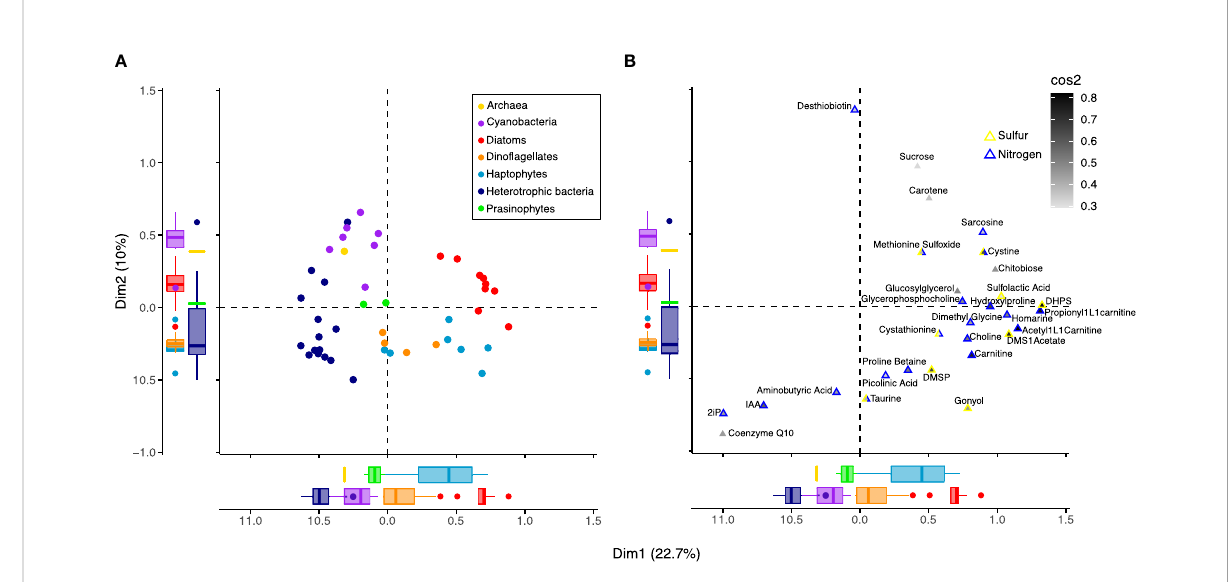
FIGURE 5 Associations between microbial groups and metabolites. Ordination based on Multiple Correspondence Analysis (MCA) using presence-absence of 53 metabolites in 42 organisms, with individuals (A) plotted separately from metabolites (B) . Metabolites found in all organisms ( n =4), metabolites found in <3 organisms ( n =20), and universal metabolites ( n =36; see Figure 2) were removed, and metabolites similar to background levels were treated as absent. The fi rst two dimensions, Dim1 and Dim2, capture the greatest variation in the dataset, 22.7% and 10%, respectively. (A) Organisms (circles) are colored by group according to the legend, as in Figures 1, 2. Boxplots of the coordinates for each taxonomic group illustrate separation of groups from one another on Dim1 and Dim2. (B) Of the 42 metabolites found to have the strongest correlation with dimension axes (Supplemental Figure 4 and Supplemental Table 8), 29 were most strongly associated with Dim1 and Dim2. These 29 metabolites (triangles) are internally colored by the sum of their squared cosine (cos2) correlation values for dimensions 1 and 2 to indicate how closely their presence-absence is correlated with dimension axes. The metabolites (triangles) are externally colored according to whether they contain nitrogen (blue) and/or sulfur (yellow). The position of organisms and metabolites indicate their relationship with one another, where those with similar pro fi les are positioned closer